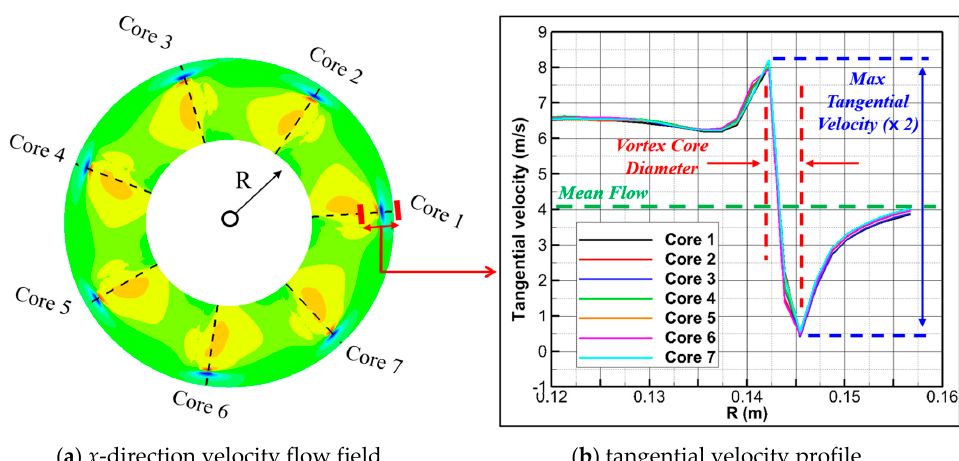
Figure 15. Schematic diagram to define the maximum tangential velocity and initial core radius of the vortex regenerated using the vortex model. ( a ) Distribution of the velocity component in the x -direction on a plane normal to mean flow. ( b ) Distribution of x -directional velocity on the lines of the constant azimuthal angle passing through the point of the maximum radial gradient of x -direction velocity.